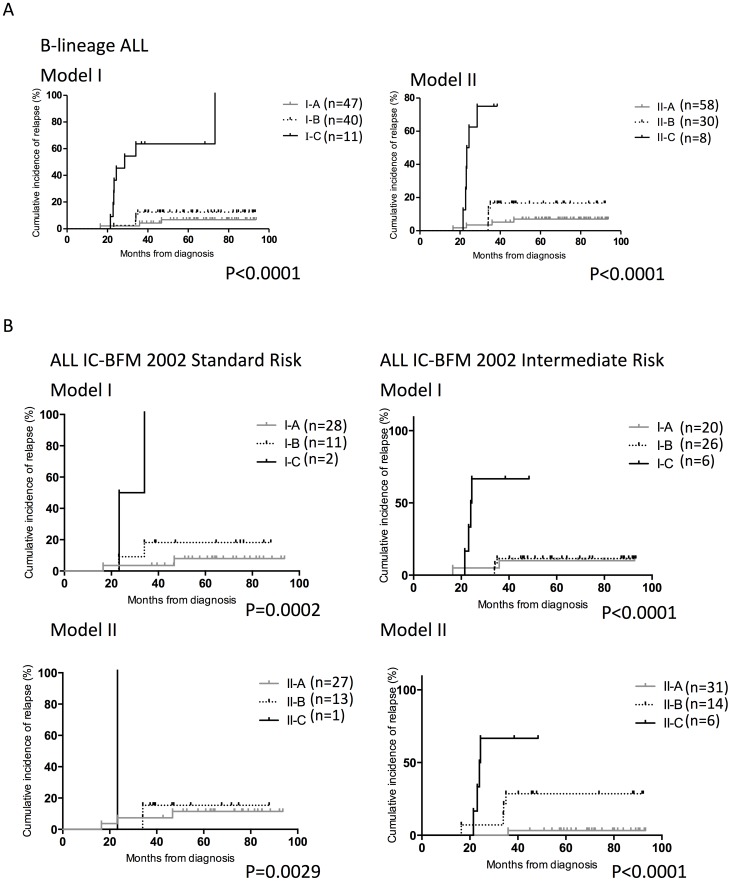
Prognostic significance of FCM MRD for patients with selected features.Incidence of relapse for patients with (A) B-lineage ALL (B) in ALL IC-BFM 2002 standard risk (left) or intermediate risk (right). Upper panels were stratified by Model I and lower panels were by Model II.